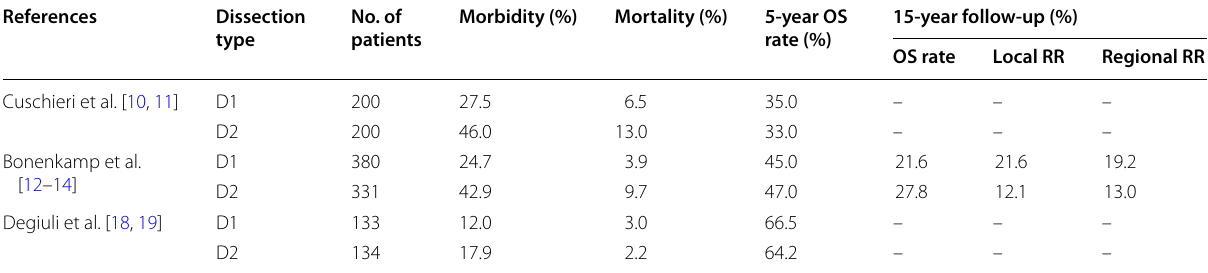
– no data available, OS overall survival, RR recurrence